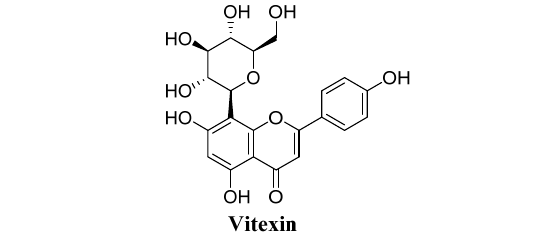
Figure 10. Orientin.